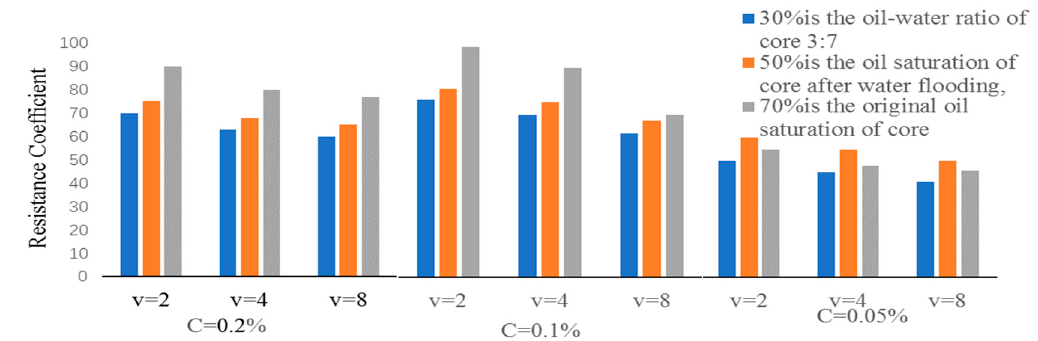
Figure 22. Cross-sectional analysis of 27 groups of emulsified resistance coefficient